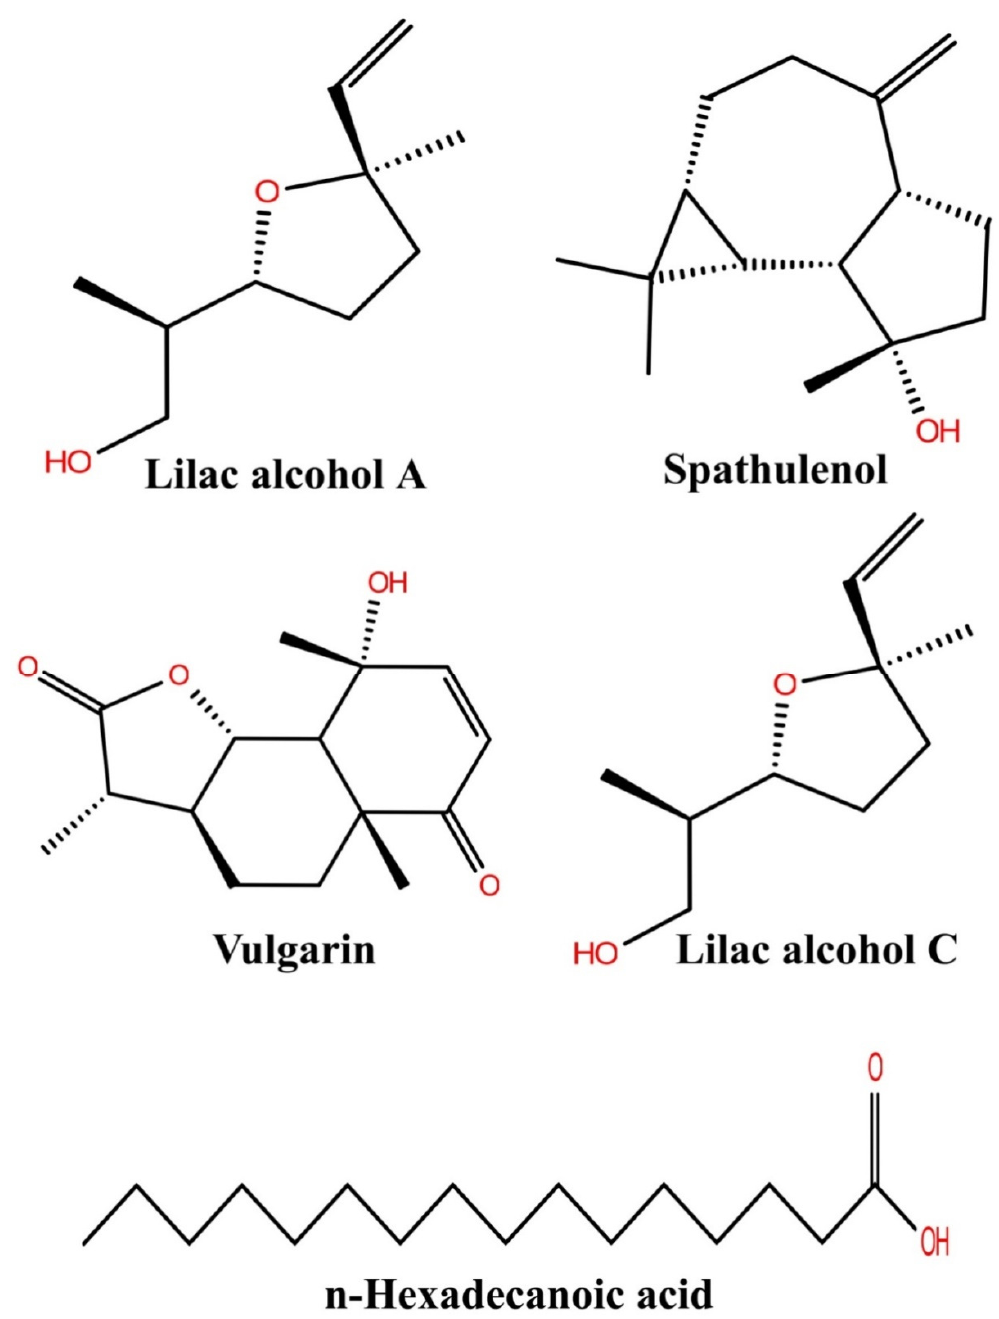
Figure 4. Two-dimensional structure of the compound isolated from the Artemisia pallans.